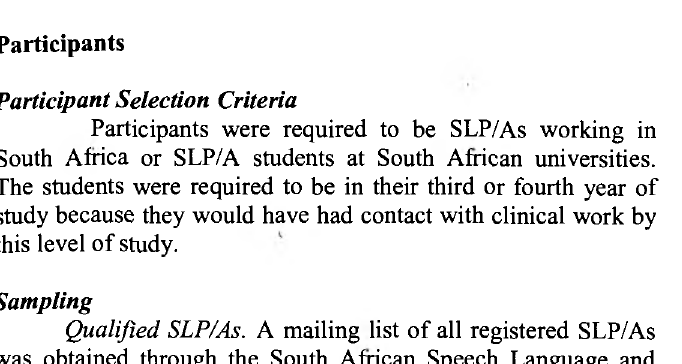
Table 1: Demographic Data of Qualified